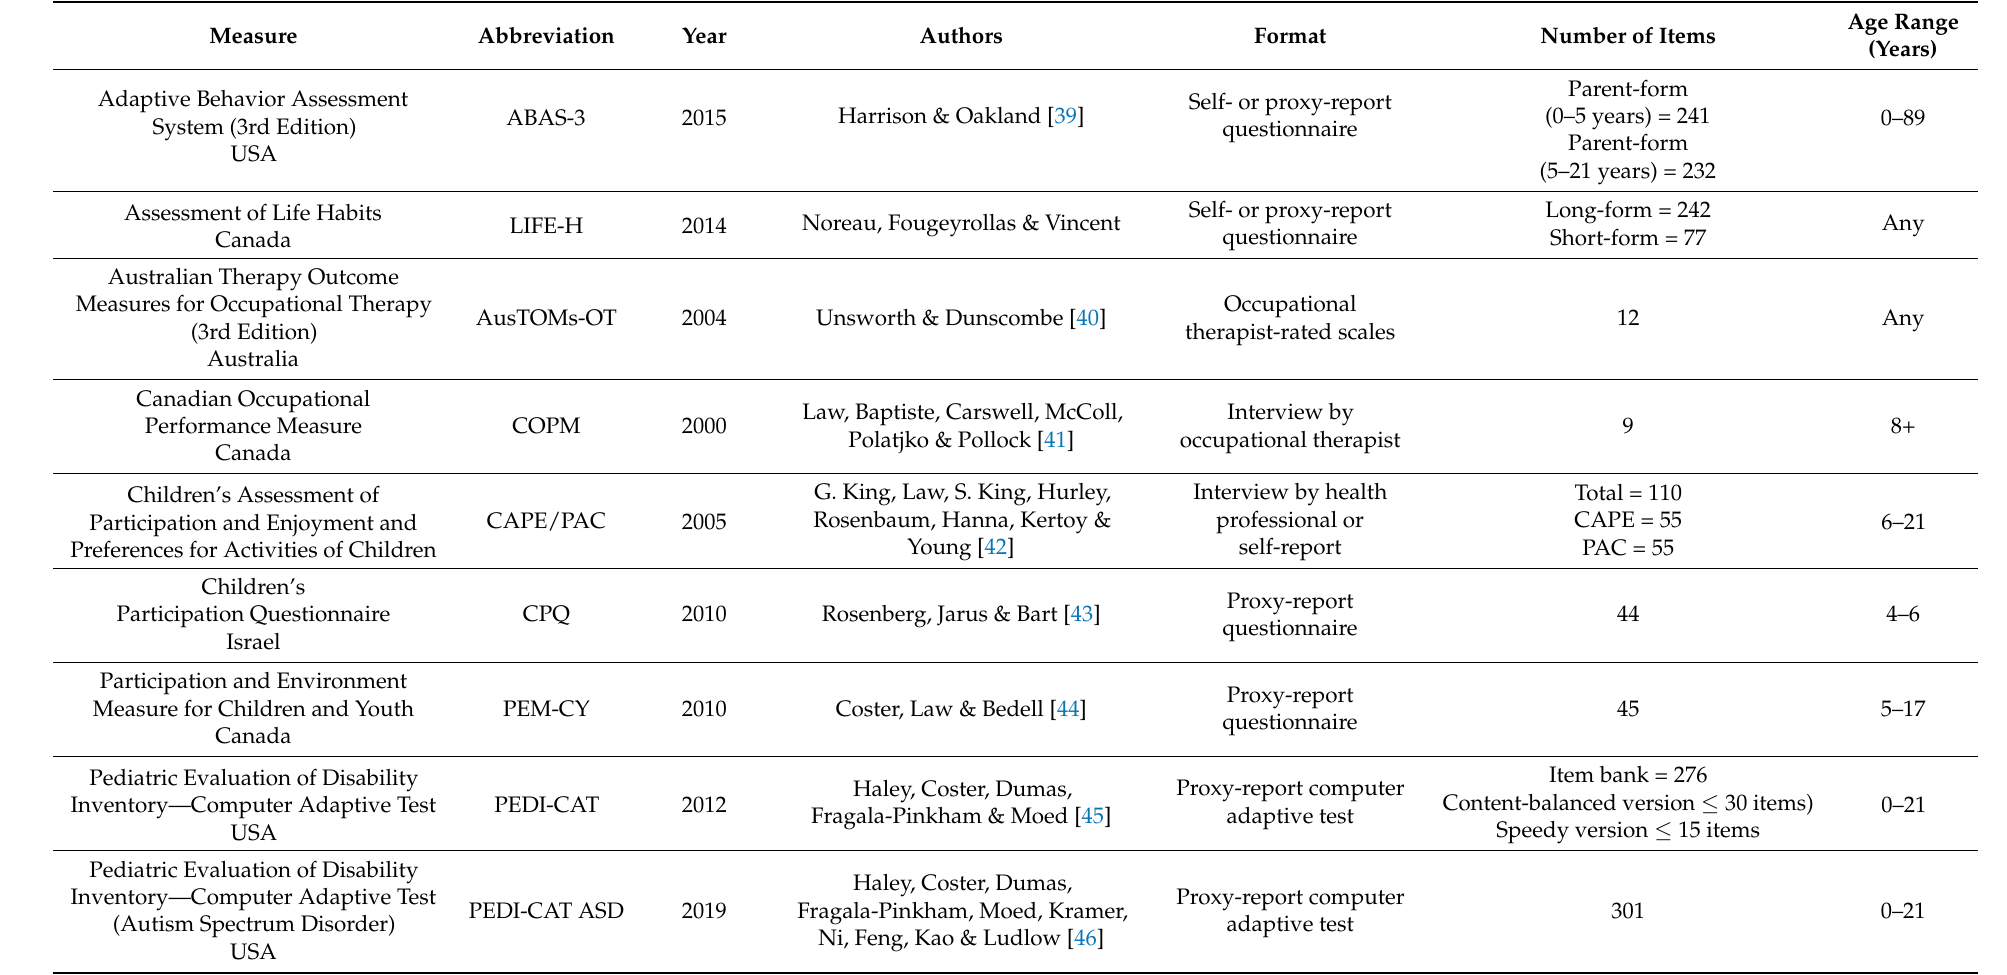
Table 2. Characteristics of included measures of